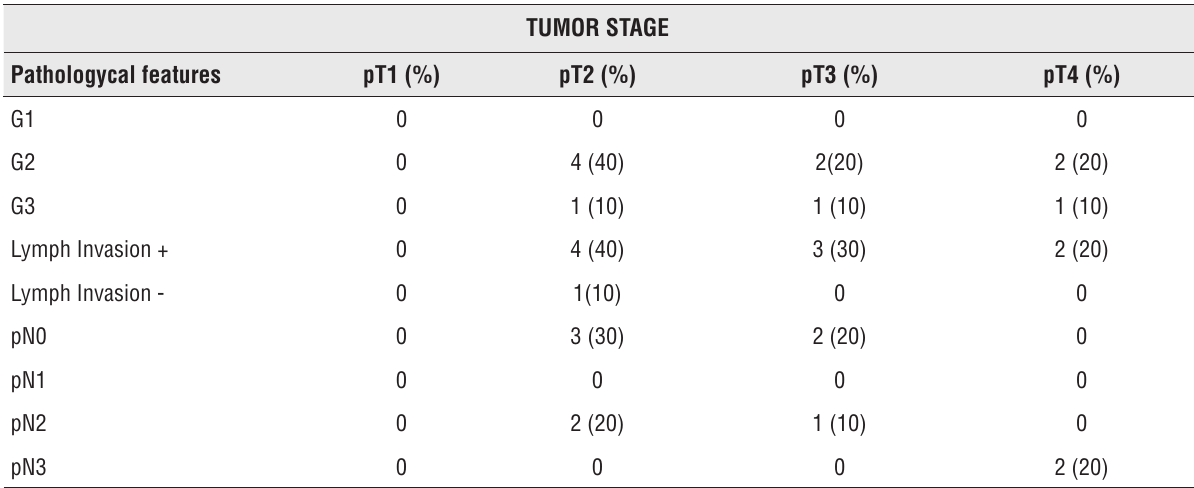
Table 2 - The table shows the pathological features and surgical stage according to 2002 TNM classification of the 10 patients with penile cancer associated to